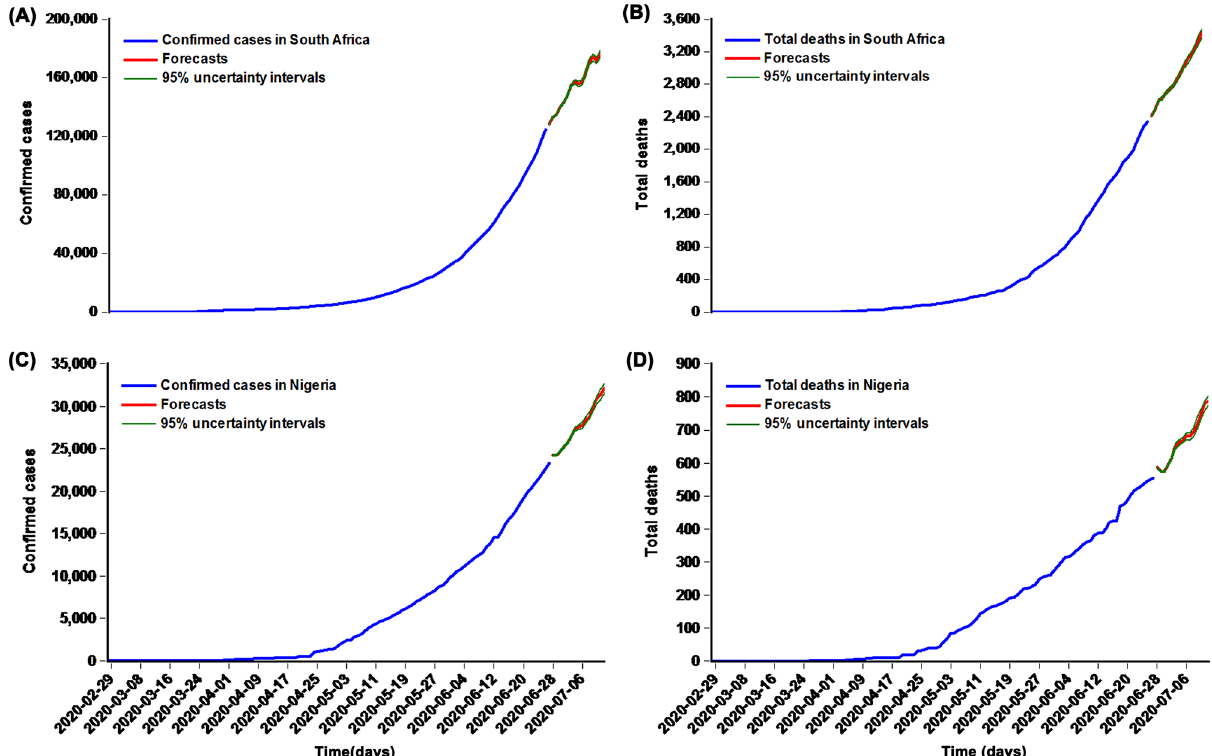
Figure 7. The next 15-day forecasts and their 95% uncertainty levels for the prevalence and mortality data using the best-fitting EEMD-ARIMA-NARANN mixture model. ( A ) The next 15-day forecasts for the prevalence data in South Africa; ( B ) The next 15-day forecasts for the mortality data in South Africa; ( C ) The next 15-day forecasts for the prevalence data in Nigeria; ( D ) The next 15-day forecasts for the mortality data in